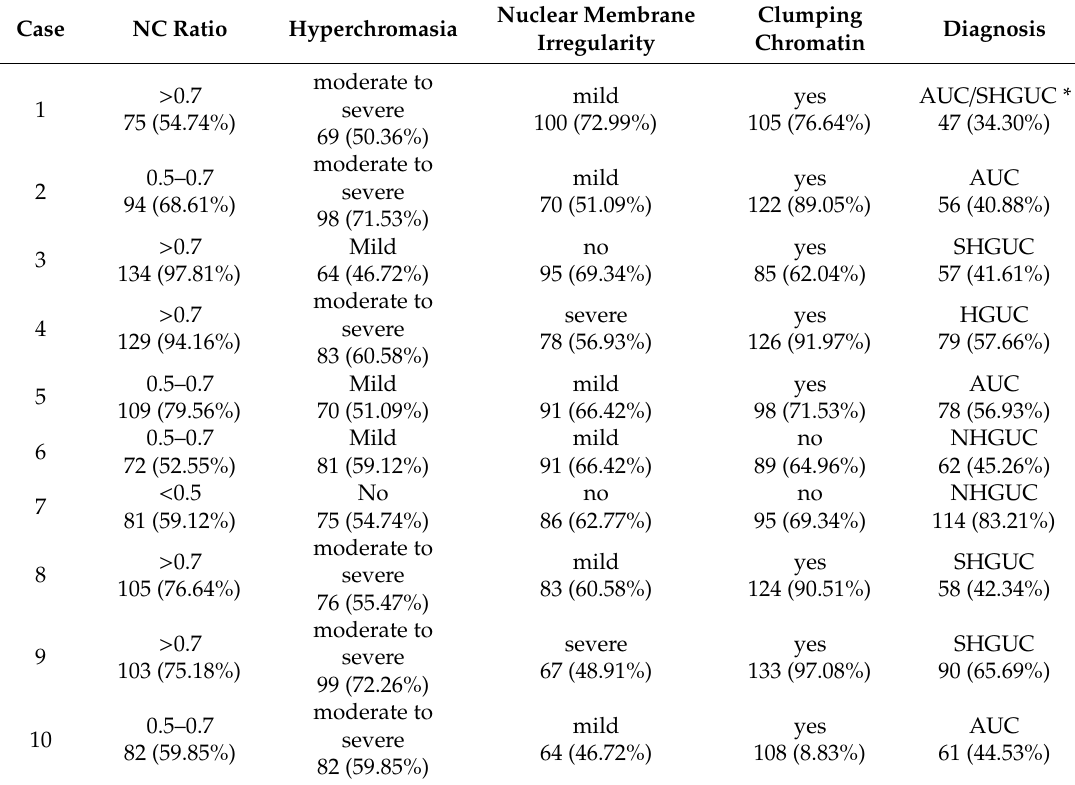
Table 2. Summary of the most favored answer from